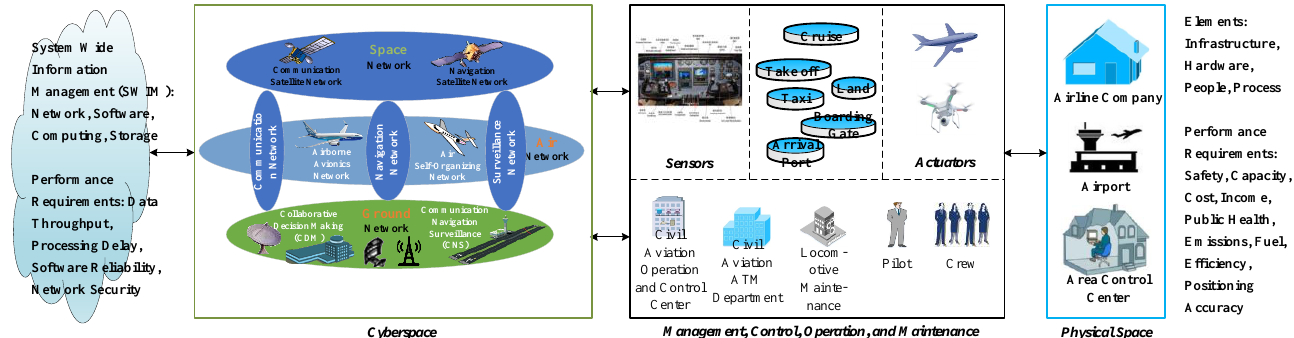
Figure 5. Networked ATM-CPS model.